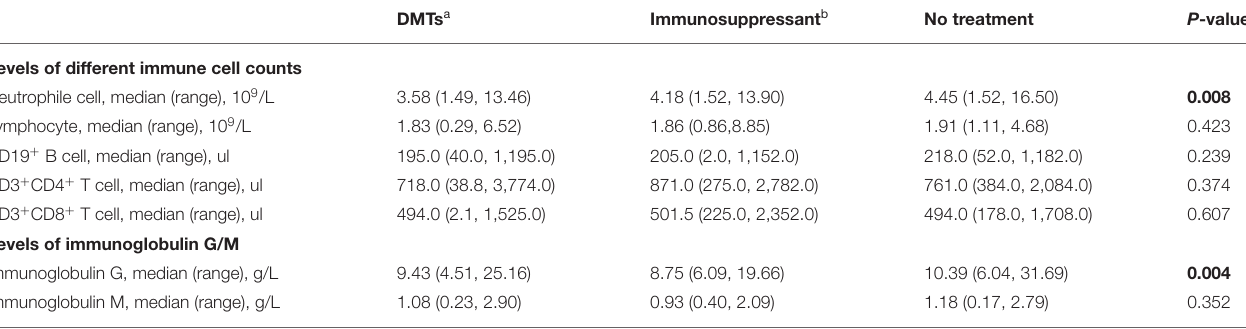
TABLE 2 | Immune status of patients with and without immunotherapy during the pandemic. DMTs a Immunosuppressant b No treatment P -value Levels of different immune cell